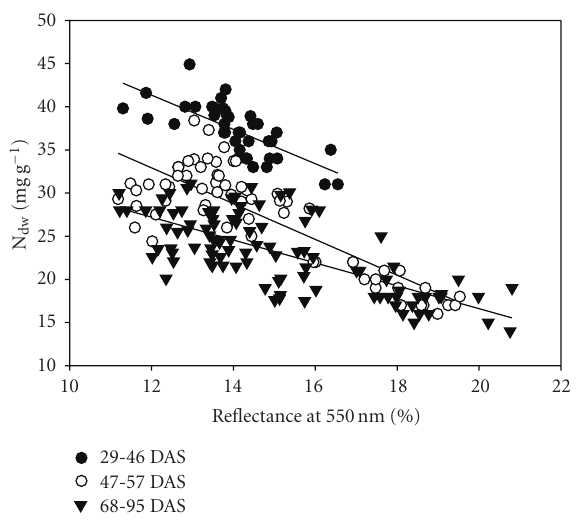
Figure 4: Reflectance at 550 nm versus leaf N concentration based on dry weight (N dw ) for all samplings and treatments ( n = 210) . Linear regression was conducted separately for three sampling periods: 29 to < 47 days after seeding (DAS), 47 to 57 DAS, and 68 to 95 DAS.